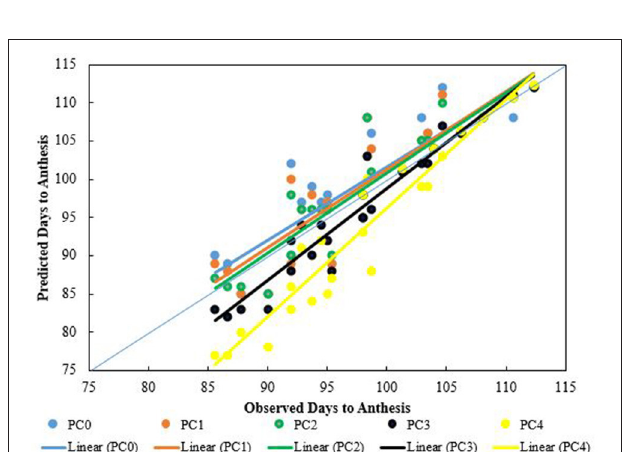
FIGURE 5 | Trend line for Wheat harvest index at Islamabad, URF Koont and Talagang including four sowing dates and 2 years as a function of (A) average temperature 7 days before and after anthesis, and (B) average seasonal temperature.